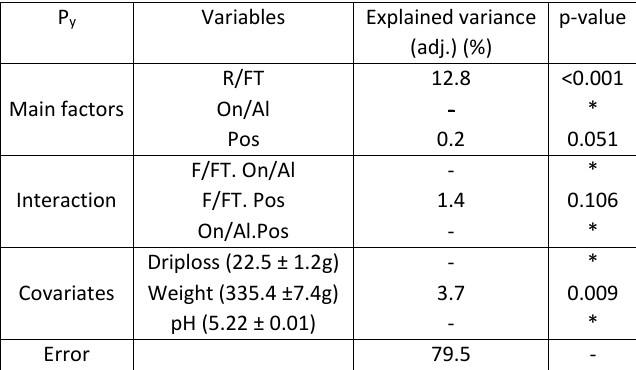
Table 1. Summary of the analyzed full factorial design (ANOVA) with P y as response and a two-level factor encoding for potentially confounding effects (R/FT = refrigerated/frozen-thawed; On/Al = electrode position ‘on - top’ into back muscle/ see Fig. 1C, D versus ‘along’, through back muscle/ see Fig. 1A, B; Pos = Position of electrode, left and right side of the sample; * = p > 0.2).